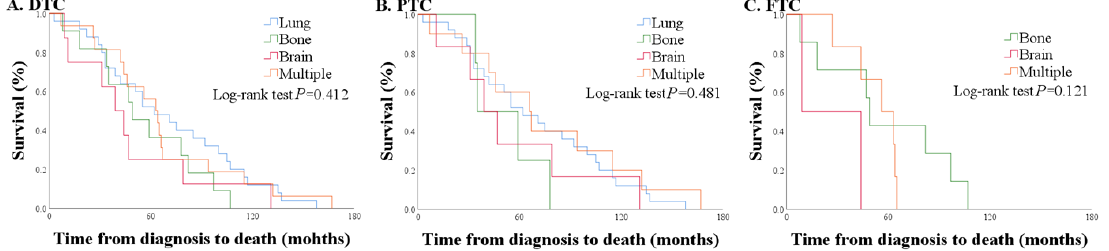
Figure 4. Comparison of overall survival according to distant metastasis site. ( A ) All WDTC, ( B ) PTC only, and ( C ) FTC only.